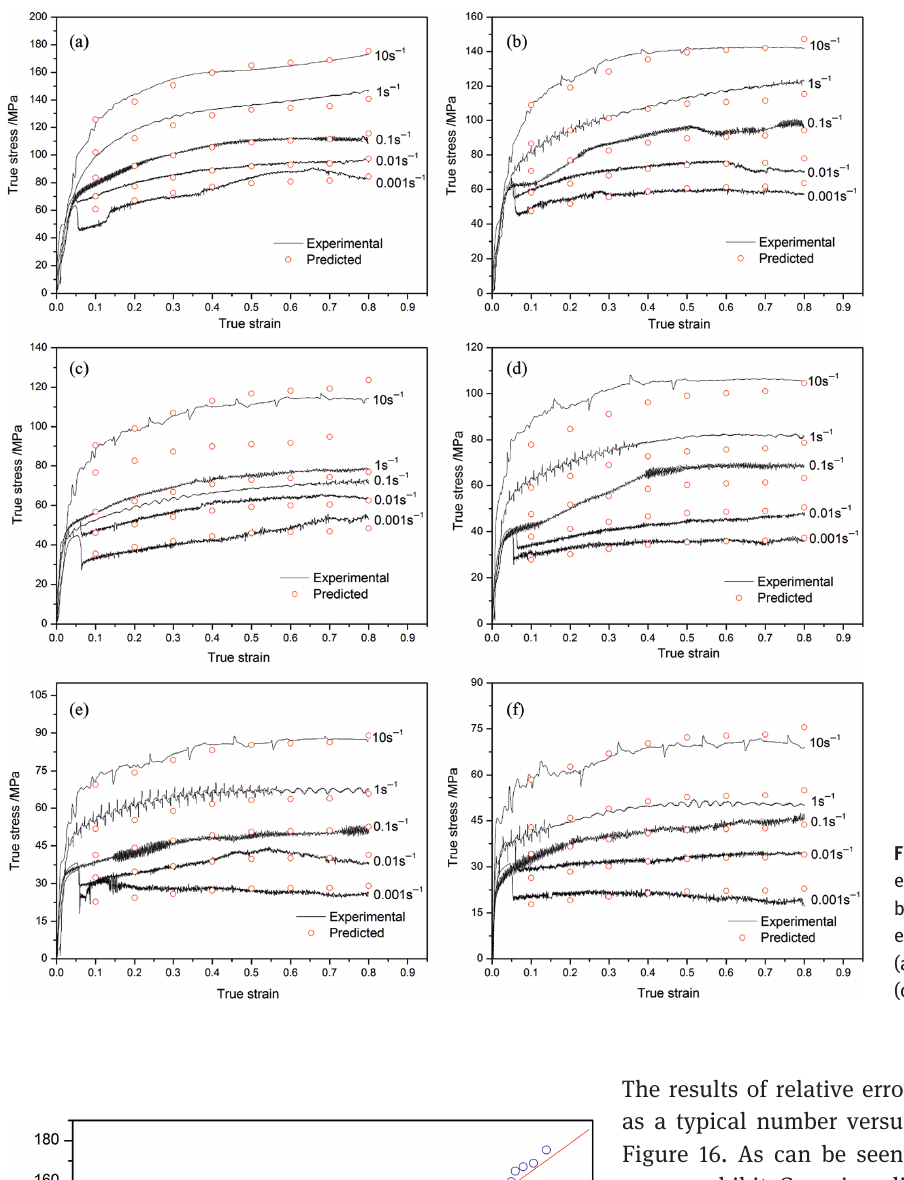
Figure 14: Comparison of the